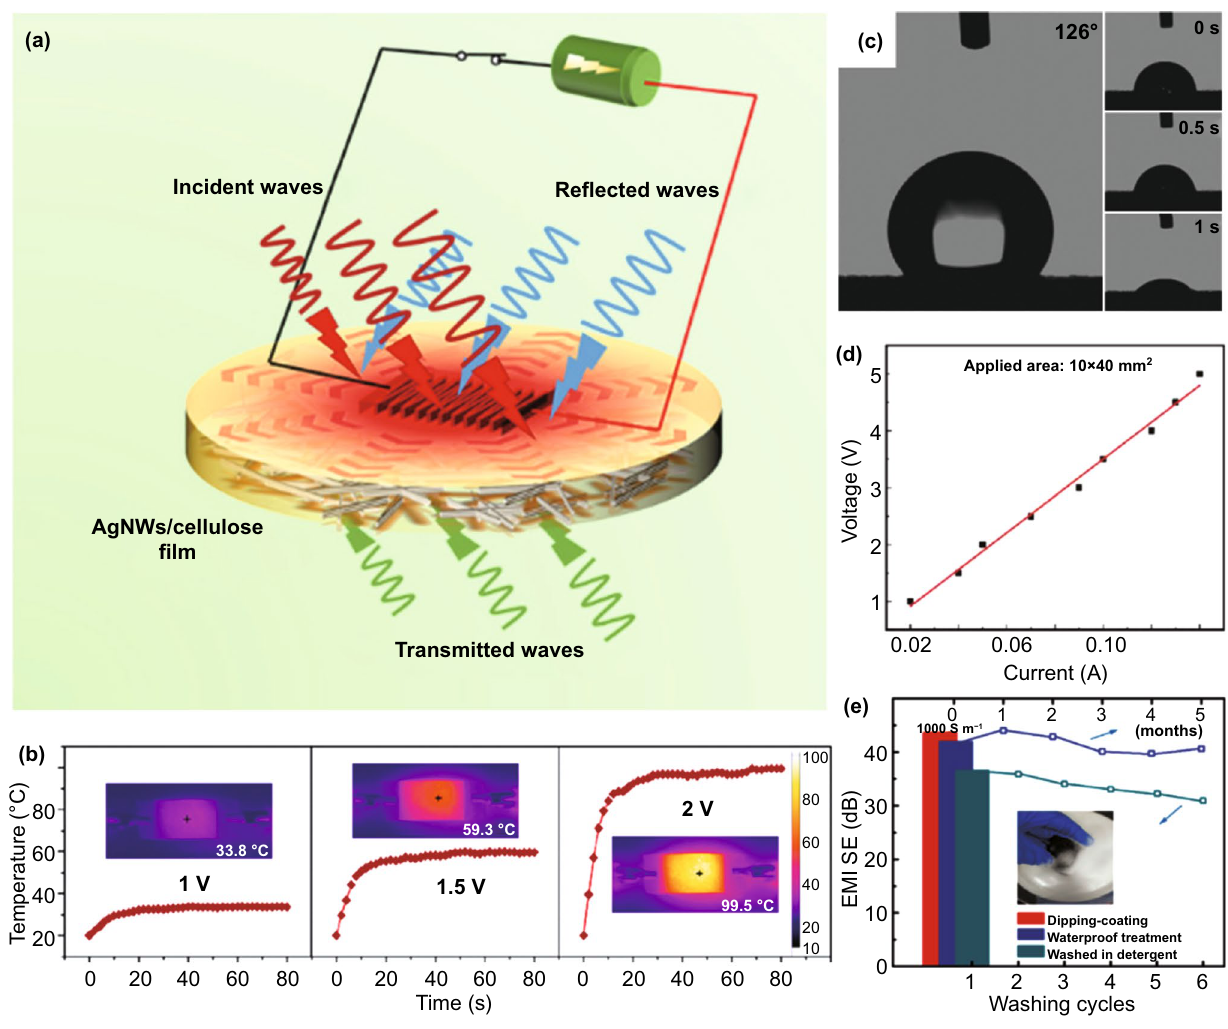
Fig. 14 a Schematic diagram of multifunctional flexible AgNWs/cellulose films; b Joule heating performances [138]. Copyright © 2020 Ameri- can Chemical Society. c Water-contacting angle measurements of M-textiles without (right) and with the coated silicone (left); d I–V curve of silicone-coated M-textile; e Effects of water-resistant treatment on the stability of EMI shielding performance [140]. Copyright © 2018 WILEY ‐ VCH Verlag GmbH & Co. KGaA,